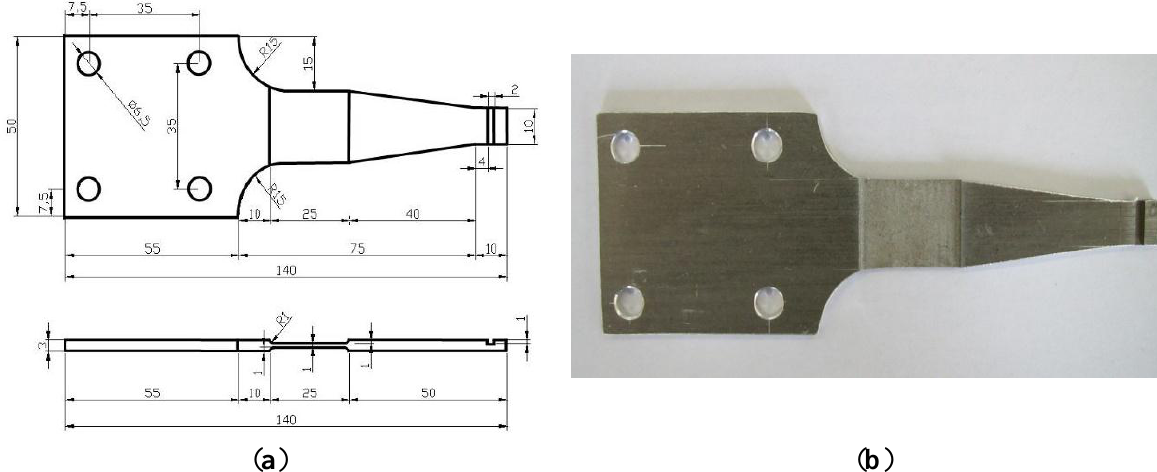
Figure 19. Design of the specimen. ( a ) Geometry parameters of the specimen; and ( b ) Photo of the specimen.